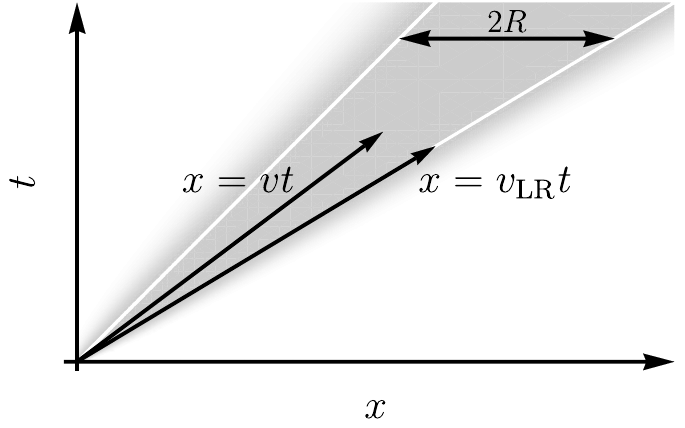
Figure 1: Operator growth along a ray: Schematic plot showing the definition of R ( v t , t ) . The shaded region shows the radius of support of O ≡ [ O along the ray x = v t . R is the radius of the support up to an exponential tail. Because of the Lieb-Robinson bound for O support contains the ray x = v t and is within the Lieb-Robinson